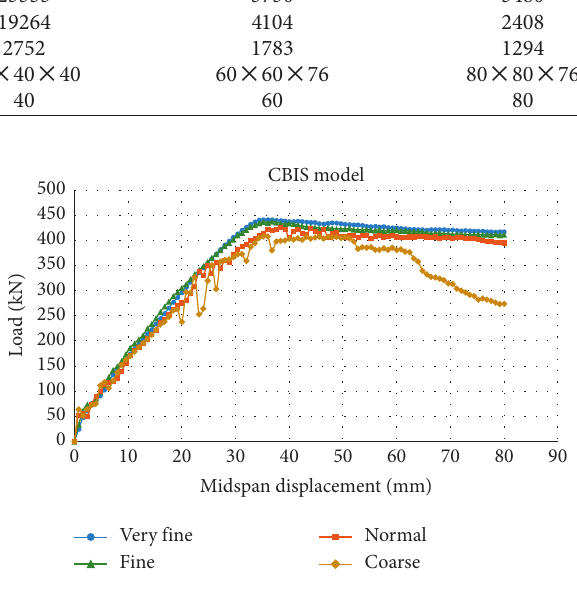
Figure 9: Mesh sensitivity results for the CBIS model.